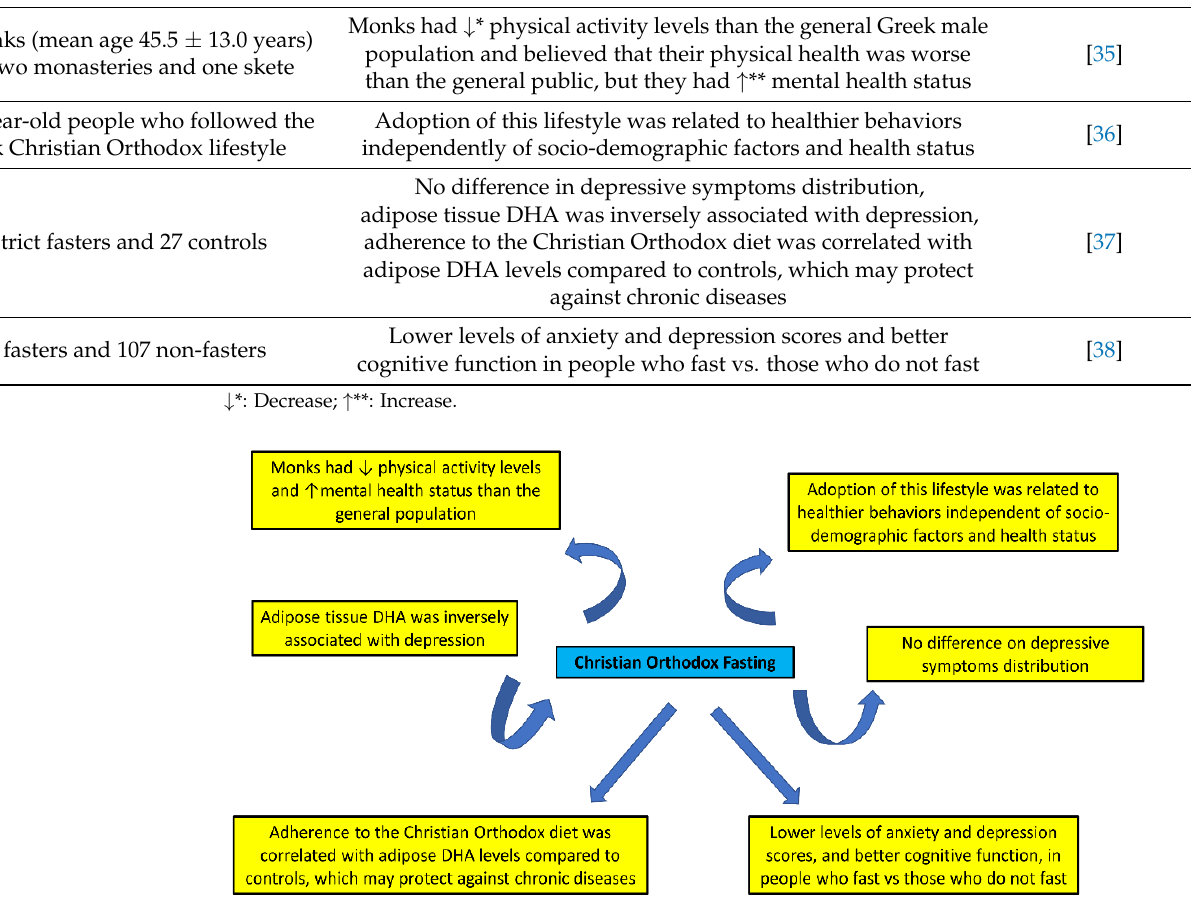
Figure 5. The potential beneficial effects of Christian Orthodox fasting on lifestyle and mental health ( ↑ : Increase, ↓ : Decrease).